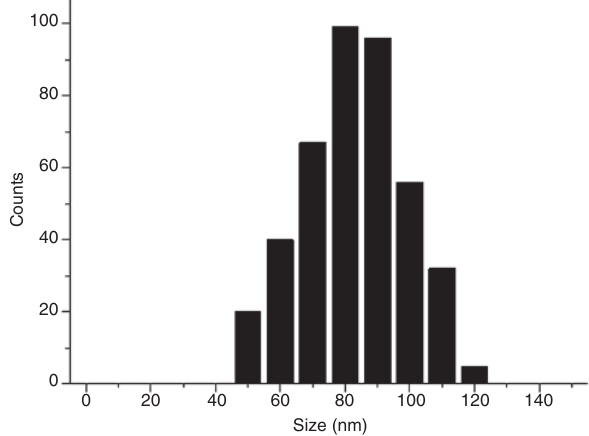
Figure 2: Particle size distribution of nano-basic silica.